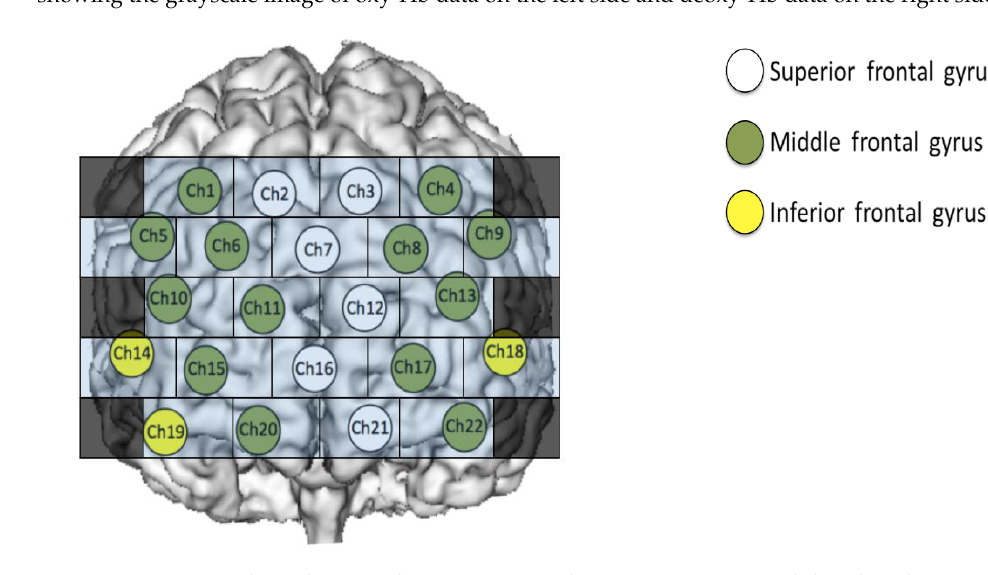
Figure 3. Correspondence between brain regions and images. It is assumed that the Hb image data and the channel (Ch) shown in Figure 2 correspond.